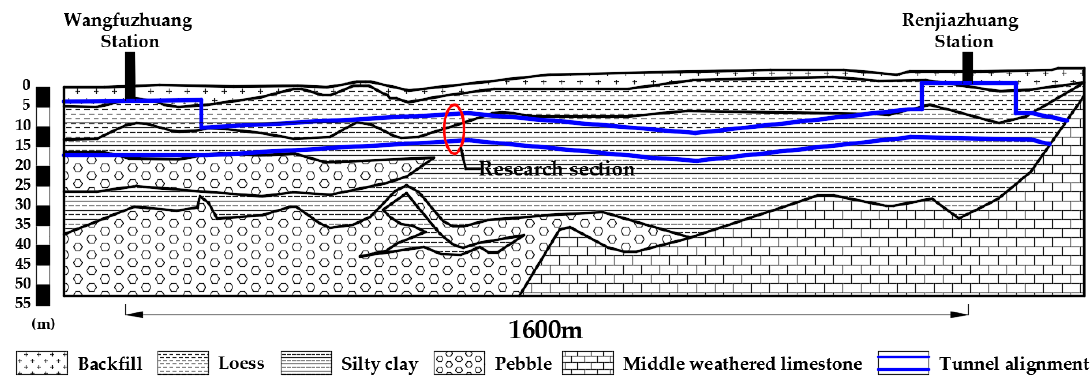
Appl. Sci. 2019 , 9 , x FOR PEER REVIEW Figure 14. Geology section of Wangfuzhuang–Renjiazhuang section of Jinan Metro Line R2. Figure 14. Geology section of Wangfuzhuang–Renjiazhuang section of Jinan Metro Line R2. Figure 14. Geology section of Wangfuzhuang–Renjiazhuang section of Jinan Metro Line R2.